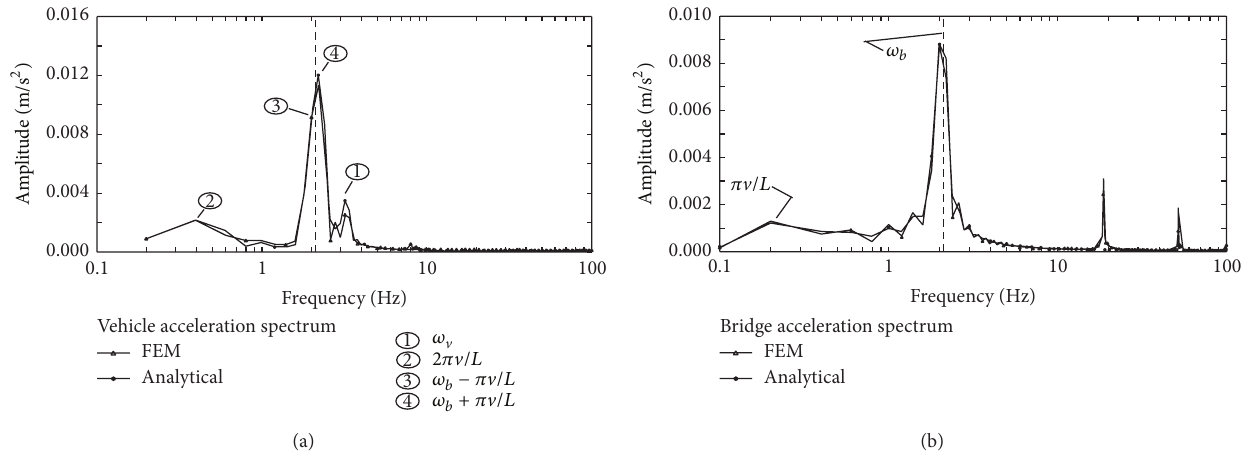
Figure 3: Vertical acceleration spectrum of (a) vehicle and (b) bridge midpoint. (Speed, V , is 10m/s, 𝜔 𝑏 is bridge natural frequency, and 𝜔 V is vehicle frequency.) After